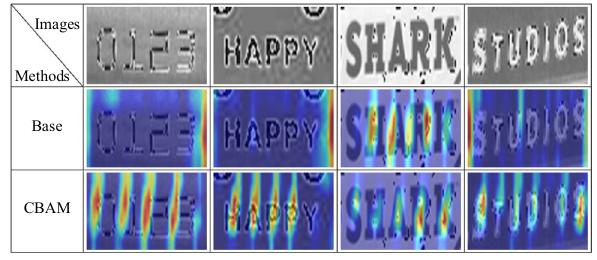
Fig. 3 Visual comparison of text recognition